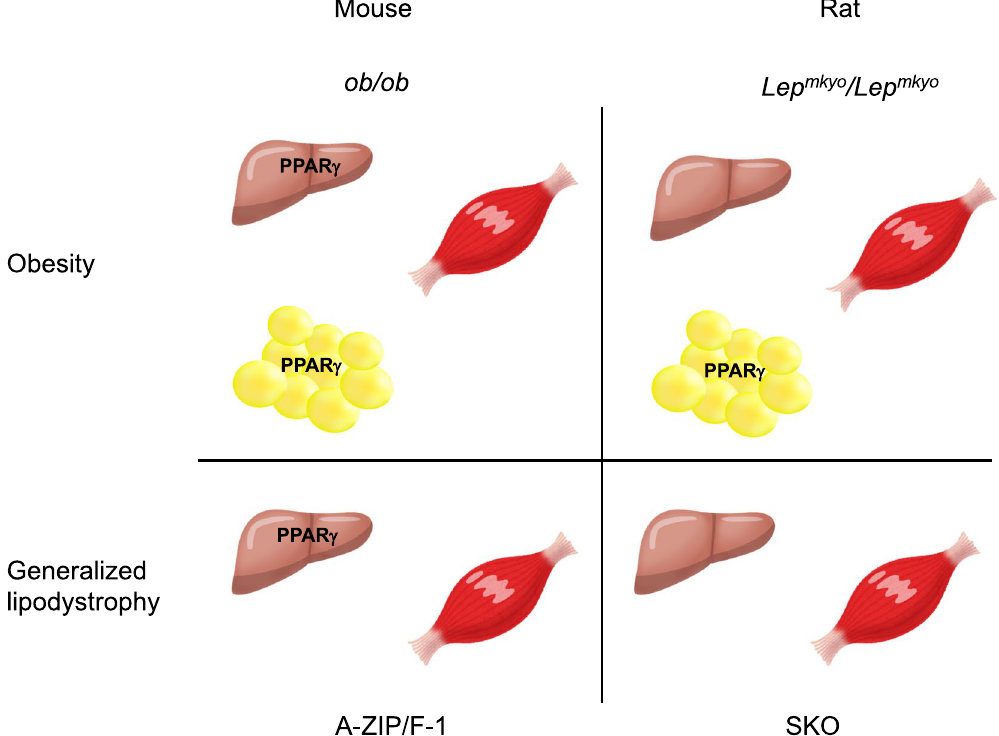
Figure 7. Expression sites of physiologically functional PPARg in mouse and rat models of fatty liver. The therapeutic target tissues of TZDs are adipose tissue and liver in ob/ob mice, liver only in A-ZIP/F-1 mice, adipose tissue only in Lep mkyo /Lep mkyo rats, and no tissue in SKO